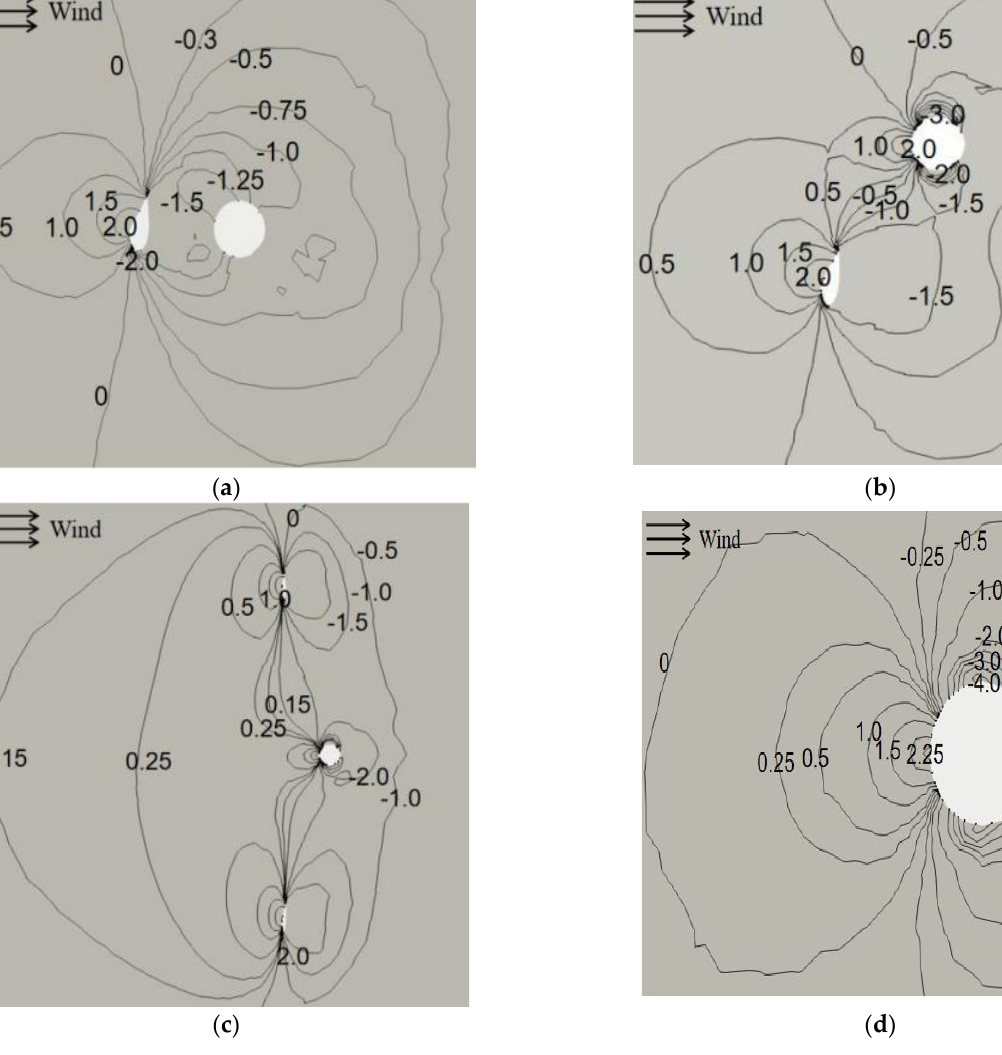
Figure 7. Wind-pressure contours of a typical section. (a) α = 0° ( b ) α = 30 ° ( c ) α = 60° ( d ) non- disturbance zone.